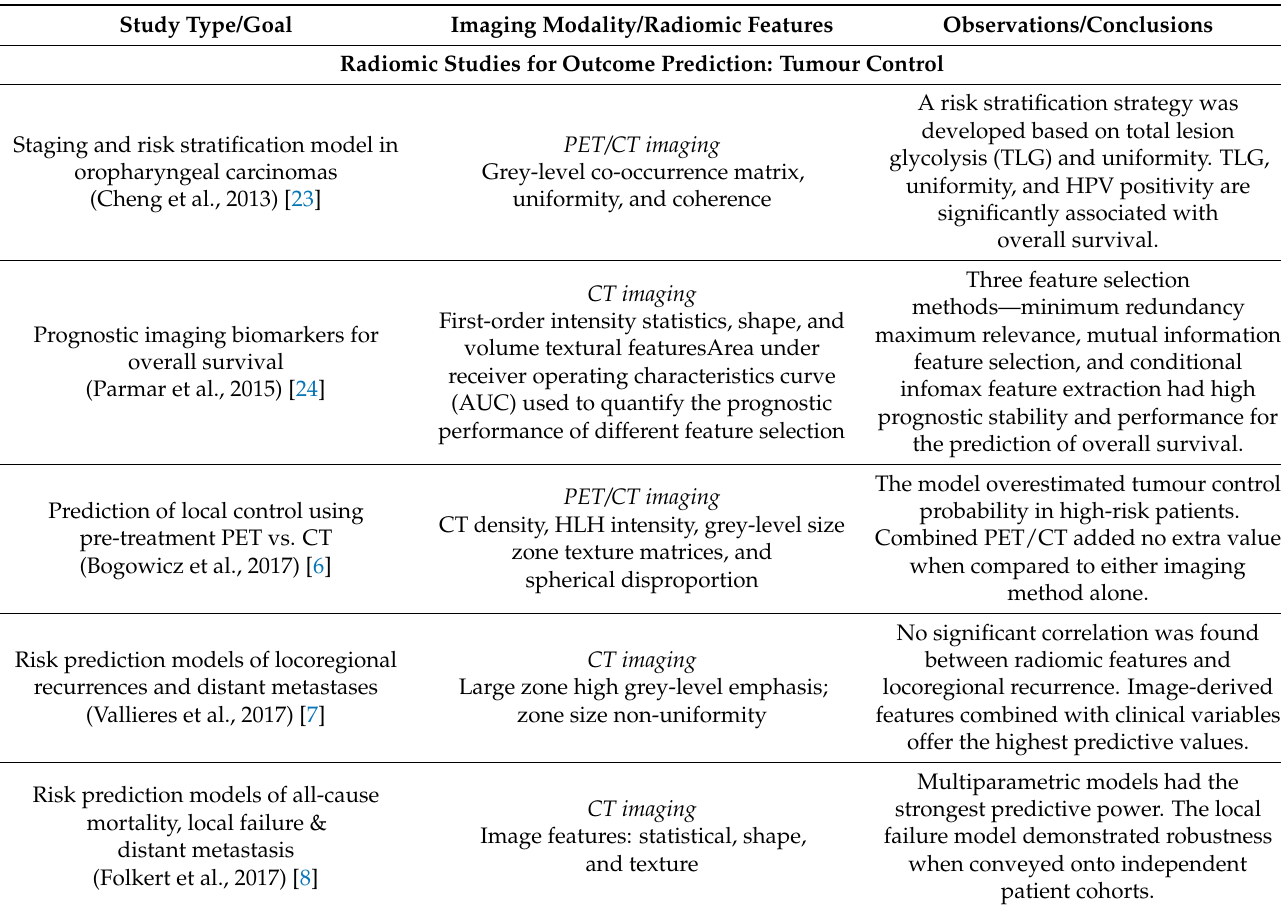
Table 1. Radiomic studies in HNC, studying tumour control and normal tissue toxicity. Study Type/Goal Imaging Modality/Radiomic